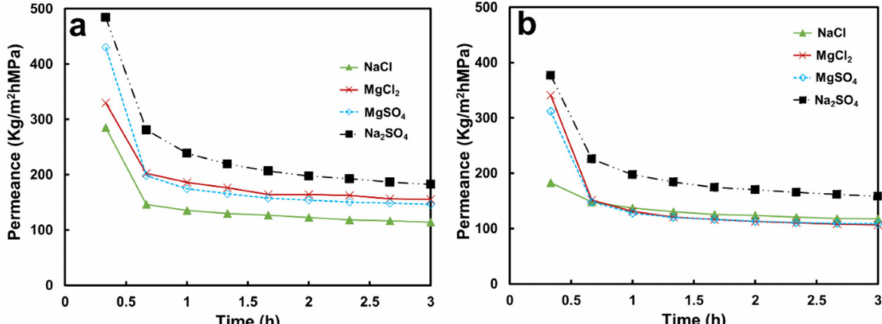
Figure 3. Time-resolved water permeance values for various salt solutions using ( a ) a non- woven/PVDF-PAA membrane and ( b ) non-woven/PVDF-PAA-GO composite membranes. Salt solutions: 2000 ppm for NaCl and MgSO 4 , 938 ppm for MgCl 2 , and 883 ppm for Na 2 SO 4 .